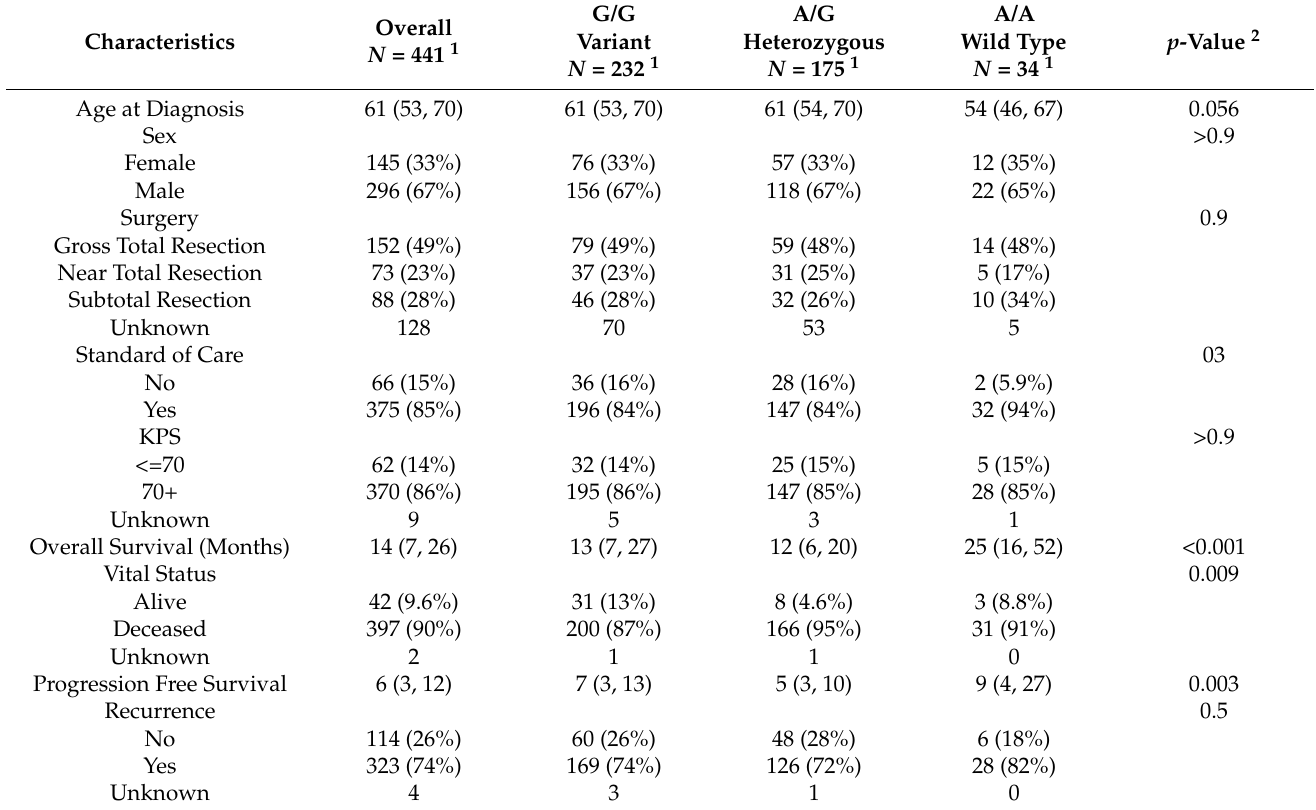
Table 1. Patient Characteristics by TSPO rs6971 polymorphism genotype from the CCF dataset.